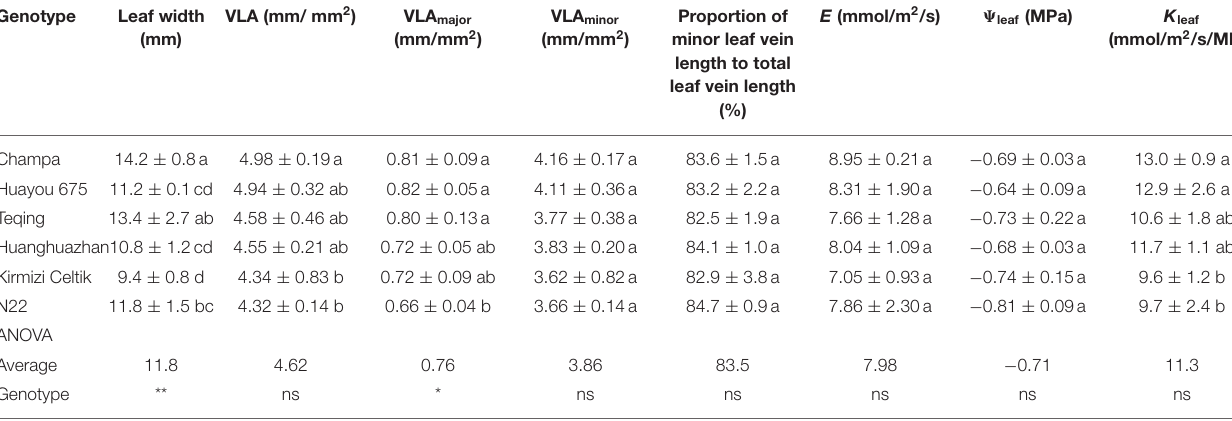
TABLE 2 | Leaf morphological traits and leaf hydraulics of the six rice genotypes. Genotype